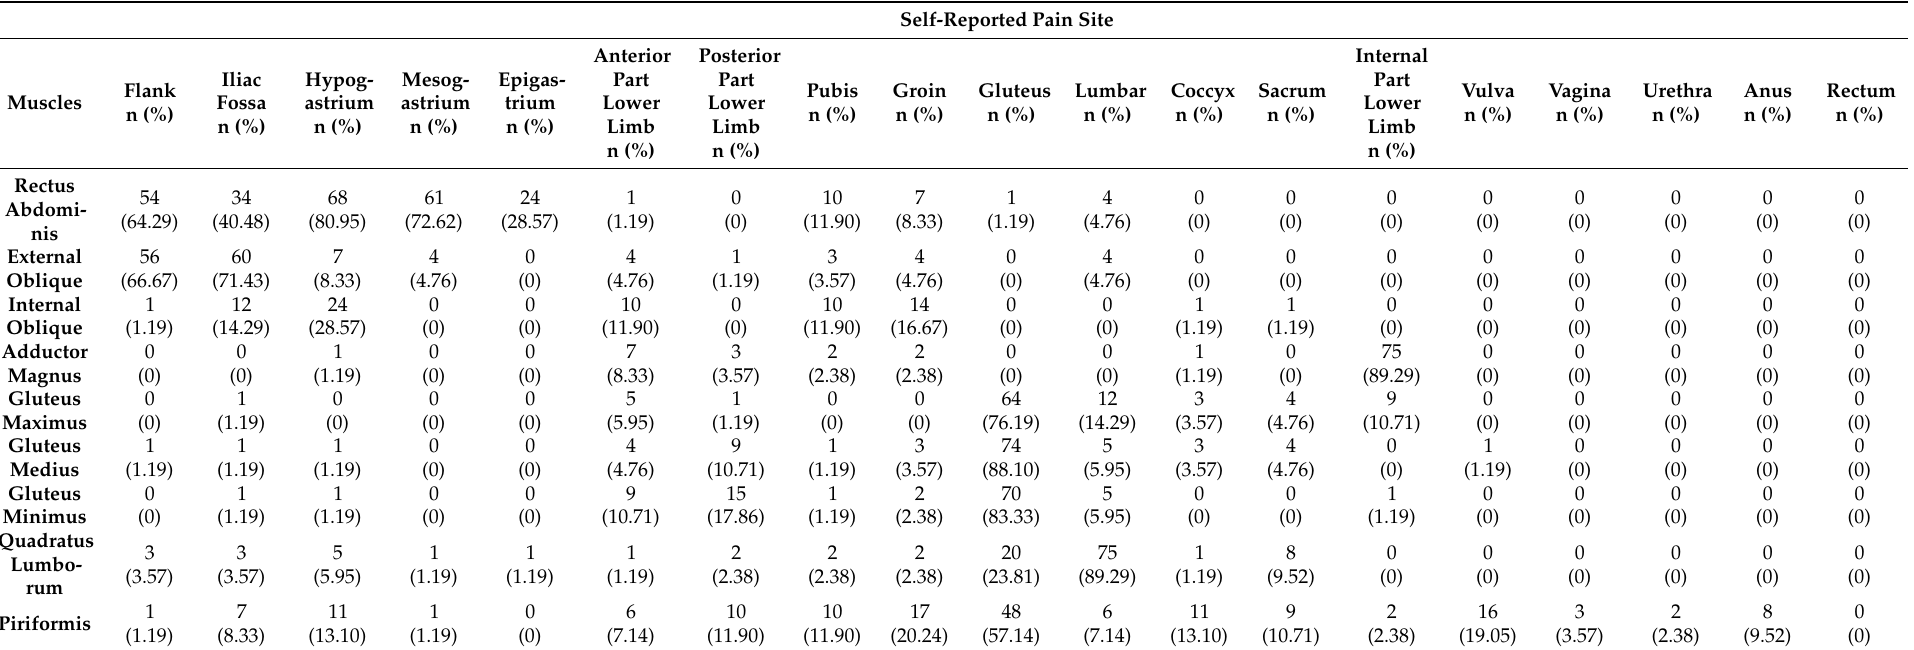
Table 9. Pain reproduced at specific sites after palpation in 84 participants during menstrual